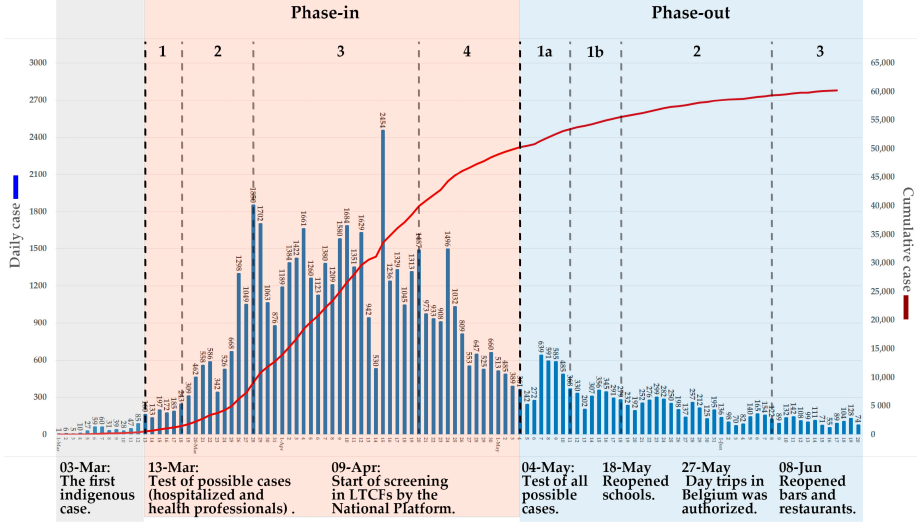
Figure 3. New and cumulative confirmed COVID-19 cases and actions were taken in